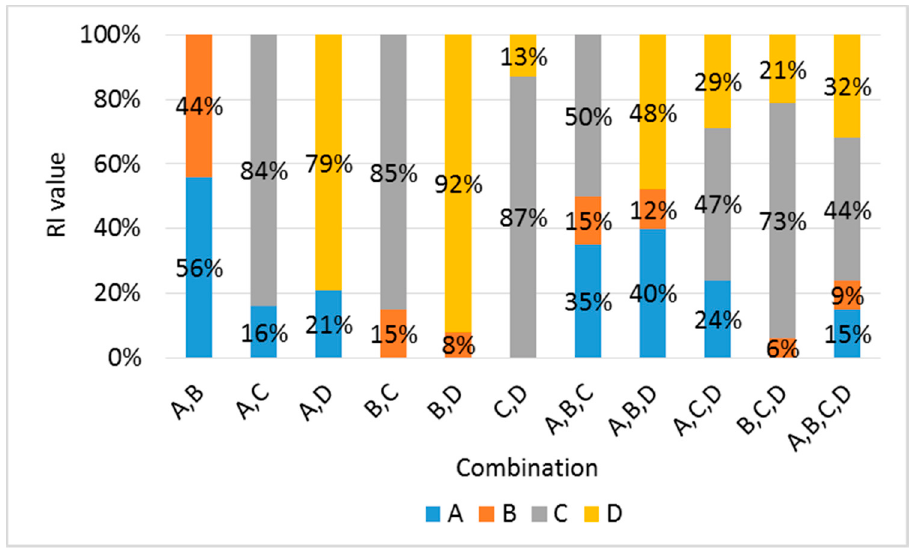
Figure 15. Comparison of RI values using the ANN method.